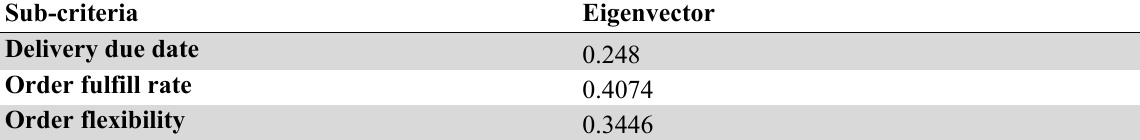
Eigenvector for the comparisons matrix of the sub-criteria of the delivery